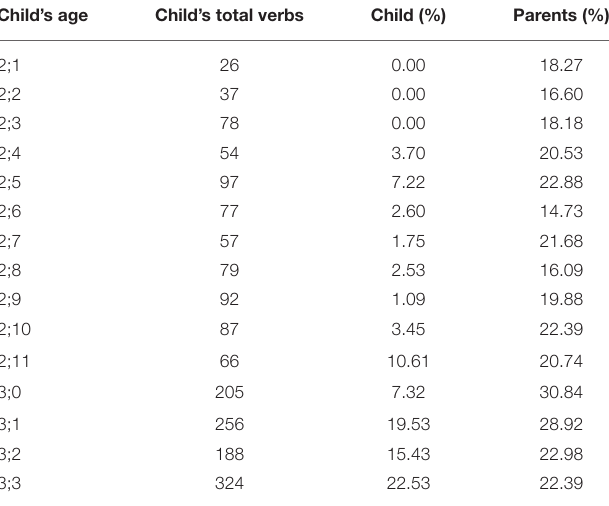
TABLE 1 | Percent medial verb distribution of all verbs in child speech and parental child-directed speech in a Nungon (Papuan) case study (cf. Sarvasy, 2019b, p. 1080, 1081,